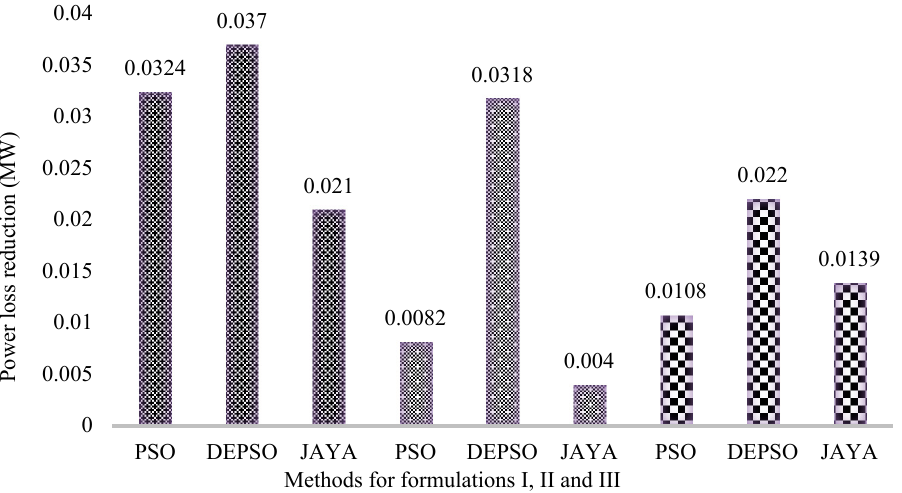
Methods for formulations I, II and III Figure 5. Power loss reduction for IEEE 30-bus